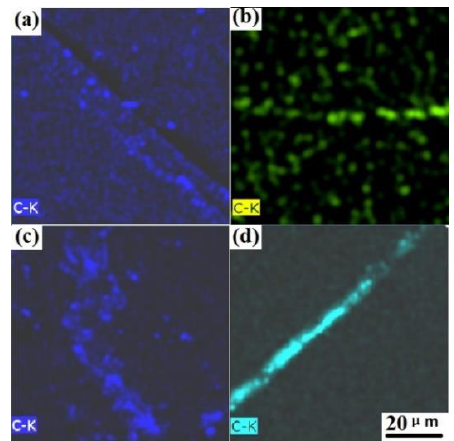
Figure 14. Carbon element distribution in the microcrack zone at different temperatures ( a ) 1050 °C, ( b ) 1100 °C, ( c ) 1150 °C, ( d ) 1200 °C.